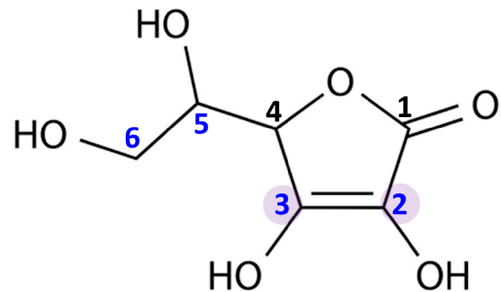
Figure 1. Chemical structure of ascorbic acid. The marked carbon atoms are important for the antioxidant properties: the carbon atoms with hydroxyl group in positions 2, 3, 5, and 6; and double bonds between carbon atoms in positions 2 and 3.